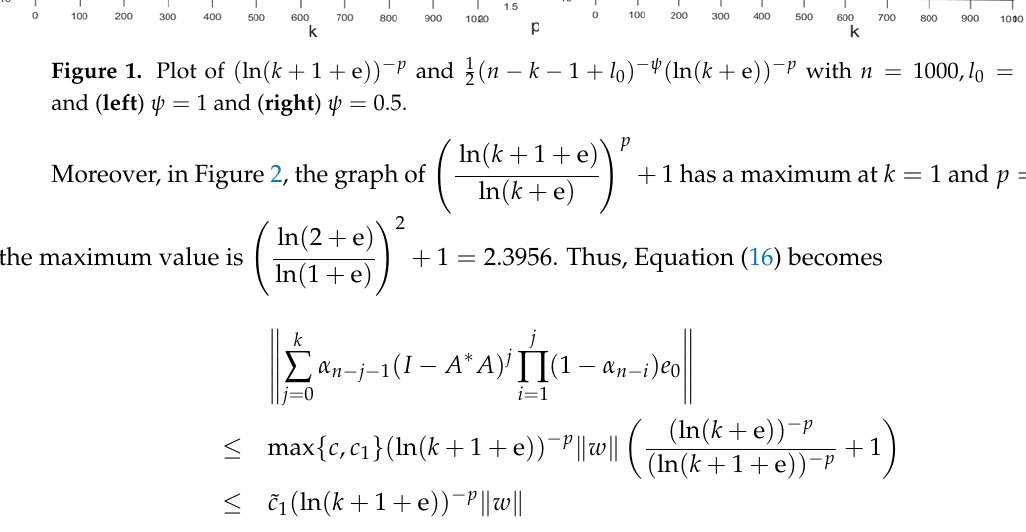
( n 1 + l 0 ) − ψ ( ln ( k + e )) − p with n = 1000, l 0 = 10, k 2 − −